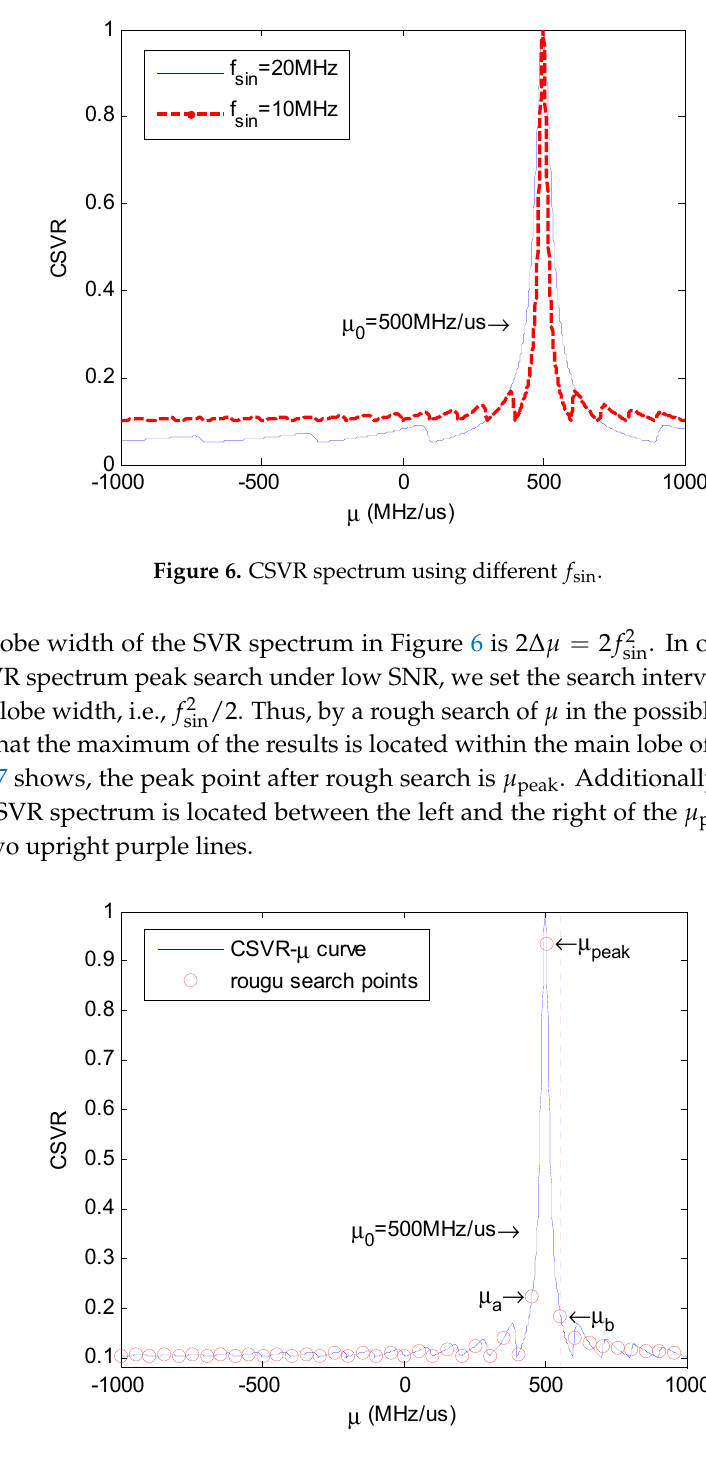
Figure 7. Rough search demonstration.